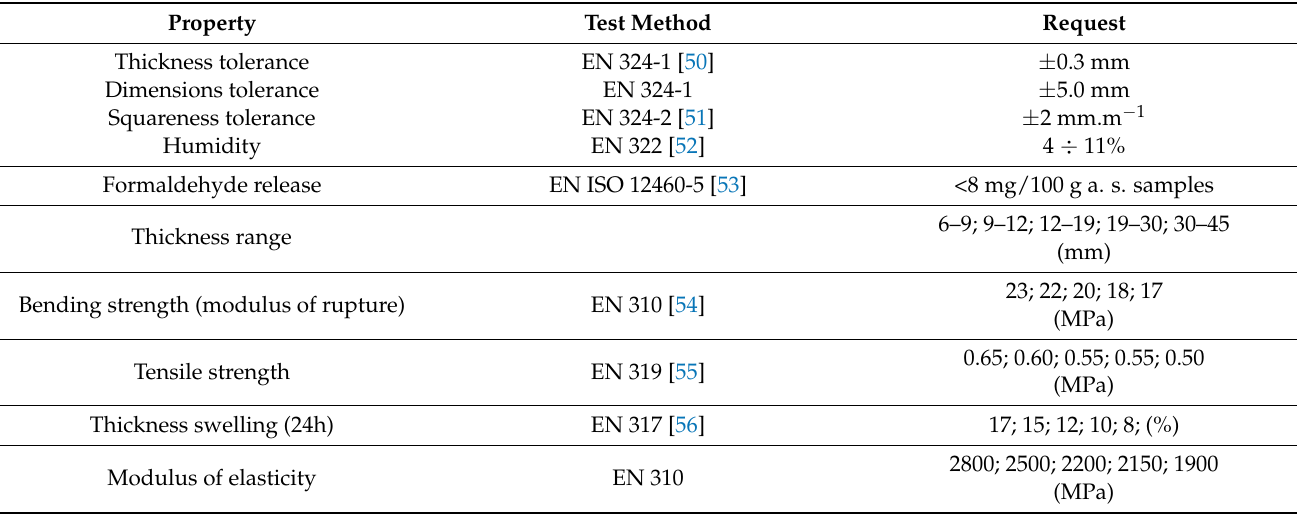
Table 4. Technical parameters of the raw MDF panels used in this